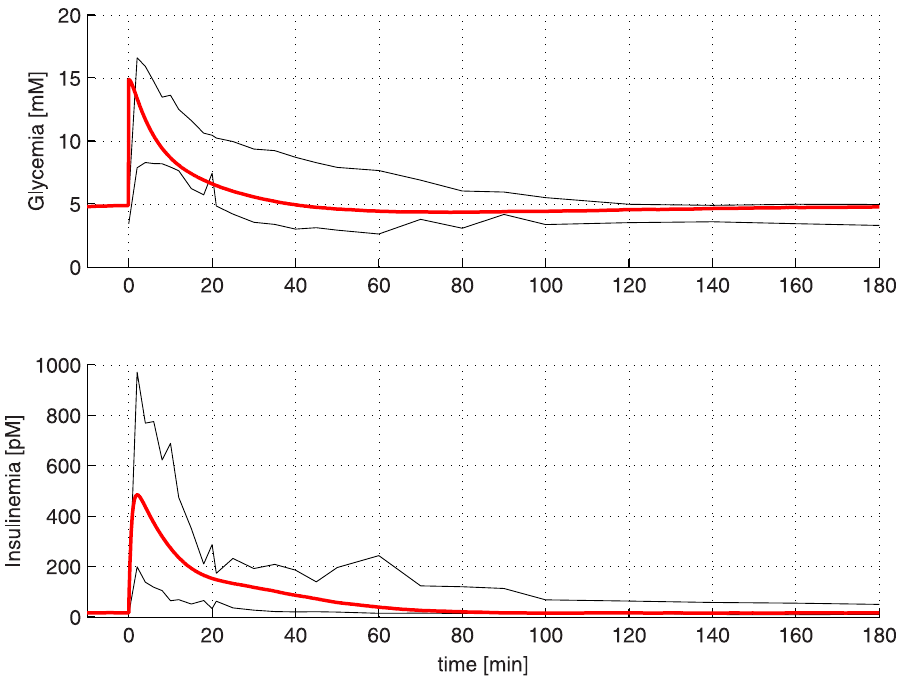
Fig 3. Median of 100 virtual NGR patients generated by the Extended Model (red curves). The black curves represent the 5th and 95th percentile of the data analyzed in [10].